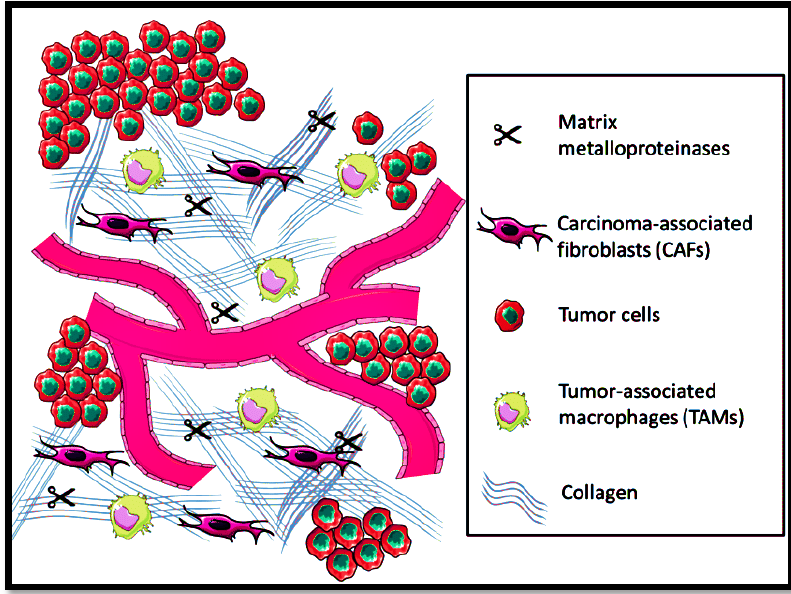
Figure 3. Tumor microenvironment prevalence in the extracellular matrix.